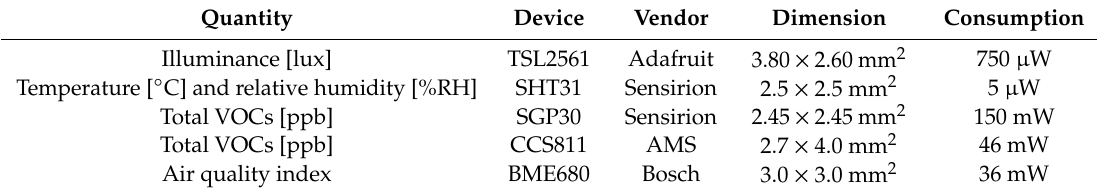
Table 1. Sensors implemented in the wireless sensor networks (WSNs). Quantity Device Vendor